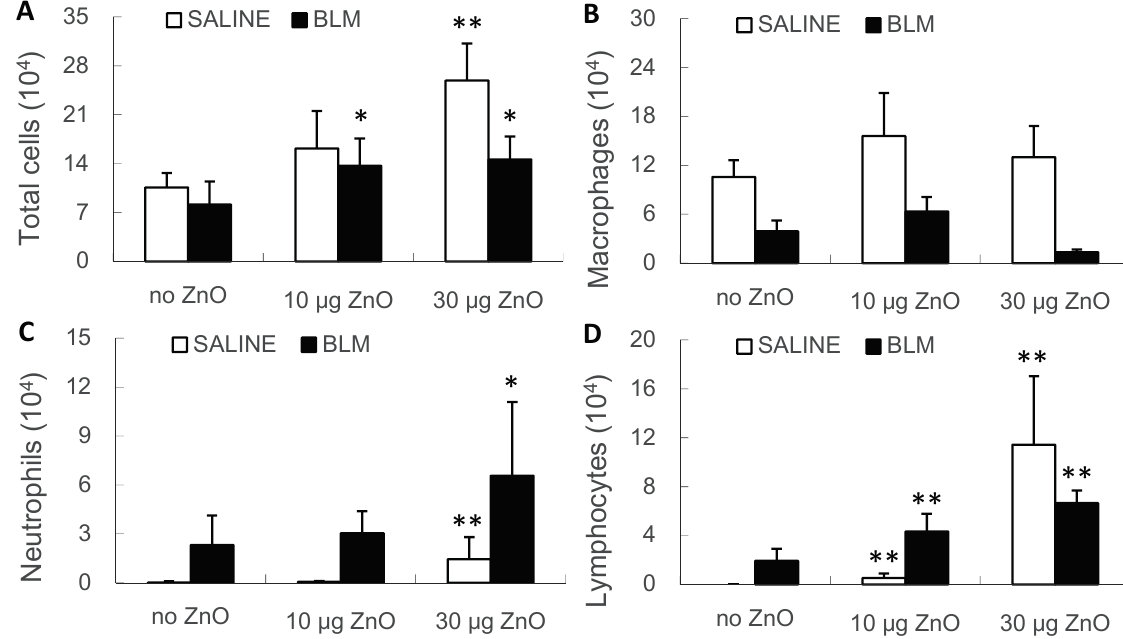
Figure 3. Total and differential cell counts in bronchoalveolar lavage fluid (BALF). Mice were exposed to ZnO nanoparticles with or without BLM treatment. The number of ( A ) total cells; ( B ) macrophages; ( C ) neutrophils and ( D ) lymphocytes in BALF were counted at Day 10 after administration. The number of mice was six in the SALINE-no ZnO, seven in the SALINE-10 µg of ZnO, six in the SALINE-30 µg of ZnO, six in of BLM-no ZnO, six in the BLM-10 µg of ZnO and seven in the BLM-30 µg of ZnO group. Data are the mean ± SD; * p < 0.05; ** p < 0.01; compared to the vehicle control.